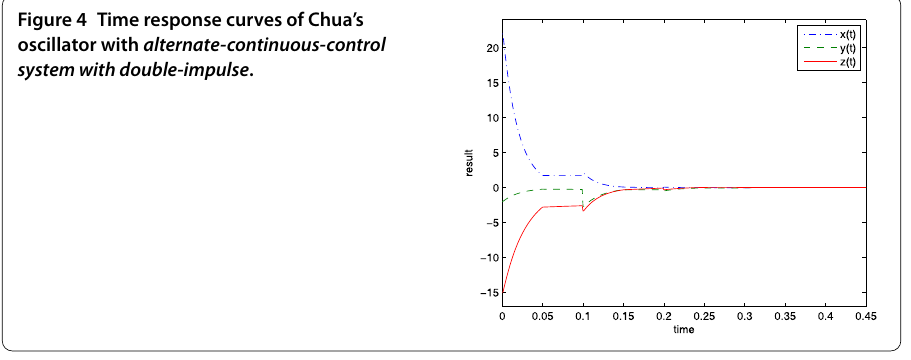
Figure 4 Time response curves of Chua’s oscillator with alternate-continuous-control systemwithdouble-impulse